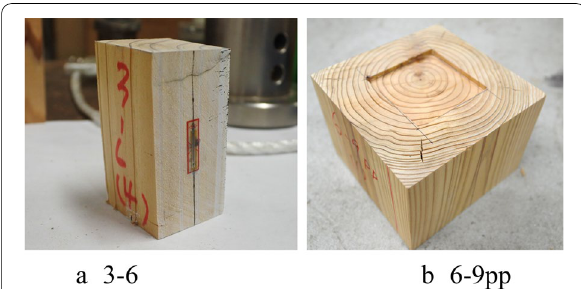
Fig. 5 Typical failure mechanisms: ( a ) large kinking, ( b ) compressive failure only under loading